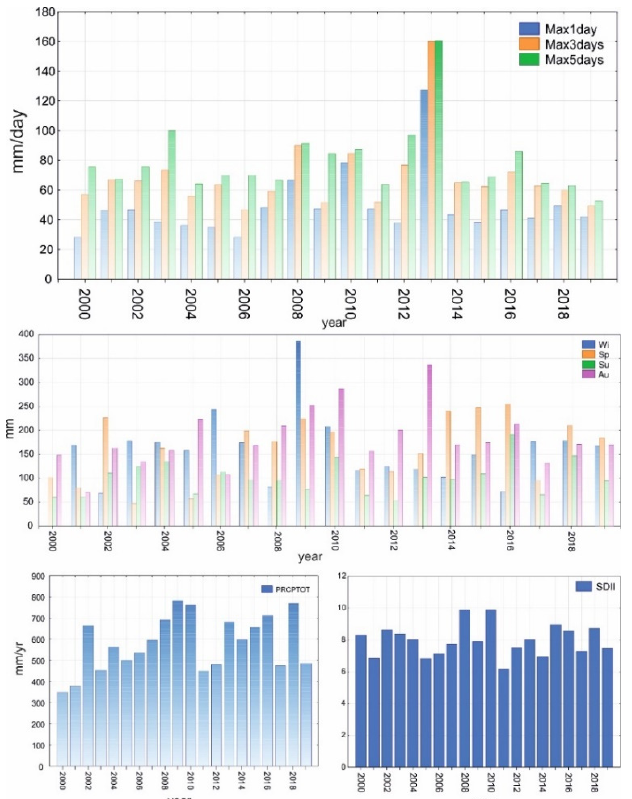
Figure 4. Climate setting of the study area as derived by the hourly rainfall record (2000–2020) of the Irsina weather station. Legend: annual maximum rainfall for 1 (Max1day), 3 (Max3days) and 5 (Max5days) days; Wi: Winter; Sp: Spring; Su: Summer; Au: Autumn. PRPTOT: total annual rainfall; SDII: ratio between the total annual precipitation and the number of annual rainy